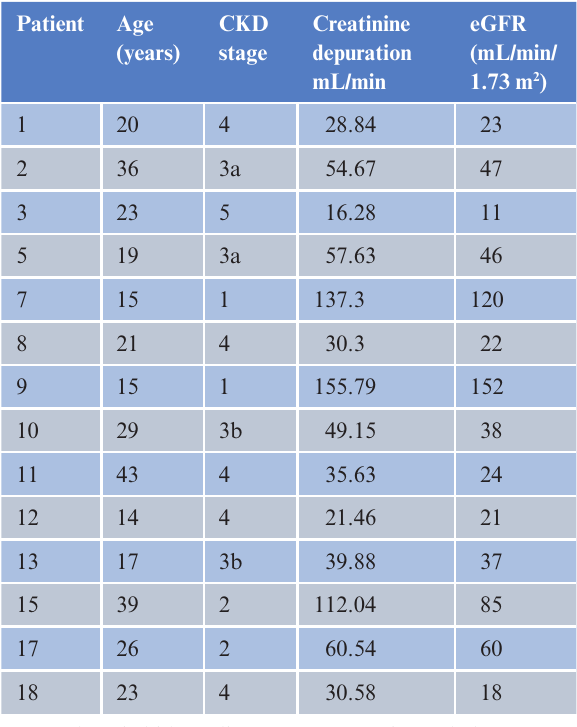
Table 3. Patient characteristics at the end of